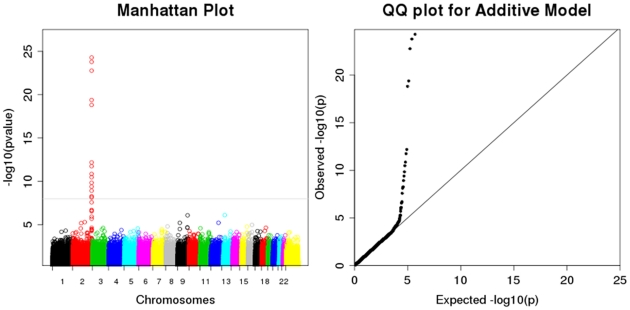
Summary of the GWAS data from the CSSCD Cohort.The Manhattan plot (A) displays the –log10(p value) of the associations tested in the CSSCD cohort using the additive model. Color bands represent chromosomes, and SNPs are ordered by their physical position within each chromosome. The large spike in chromosome 2 corresponds to the UGT1A1, UGT1A3, UGT1A8 and UGT1A10 regions. The QQ-plot (B) displays the observed (y-axis) versus expected (x-axis) –log10 (p-value). From the QQ plot, there is minimal to no inflation in the test statistic.